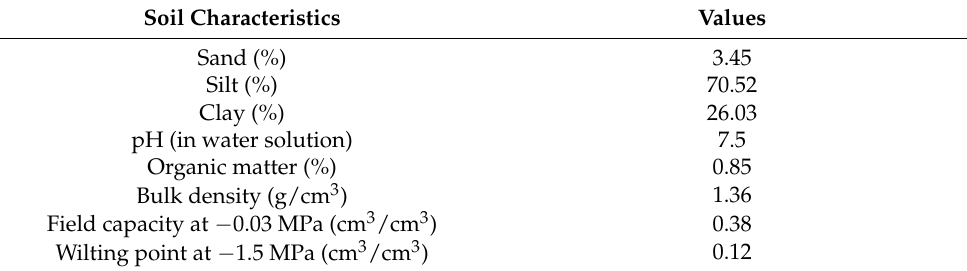
Table 1. Characteristics of the experimental soil at the upper layer (0–50 cm).